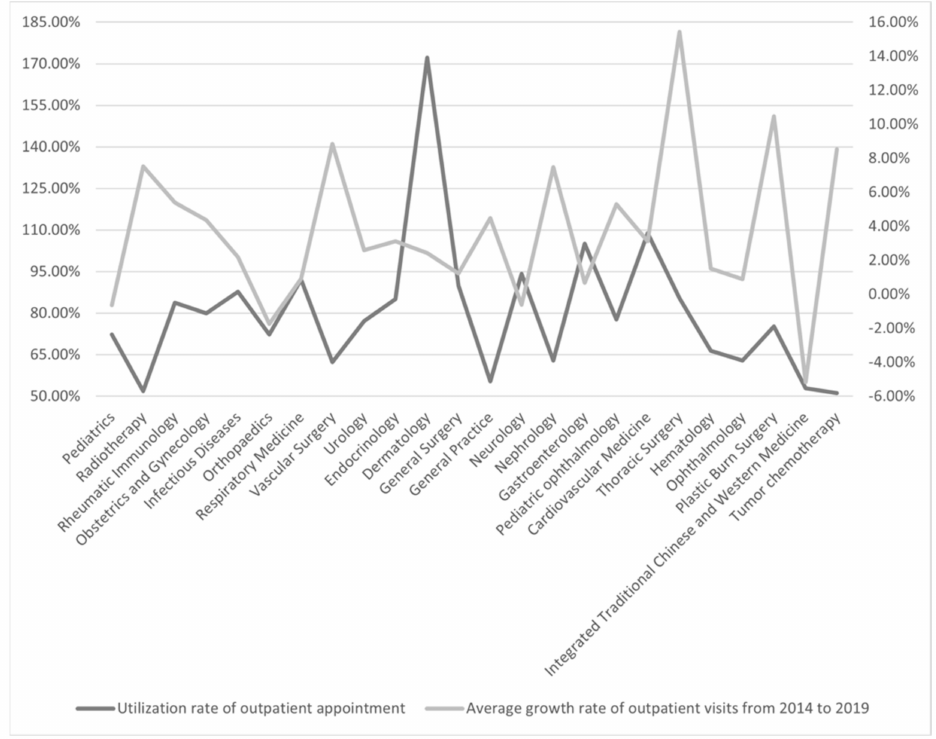
Figure 1. The average outpatient growth rate—utilization rate of outpatient appointments in different departments. Table 2. Utilization rates of outpatient appointments in each